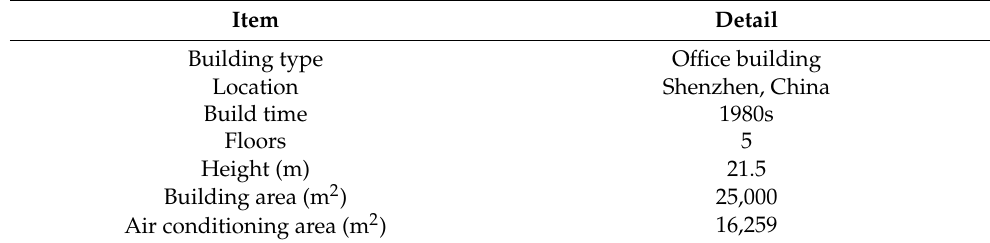
Table 1. Detailed information of the green building.